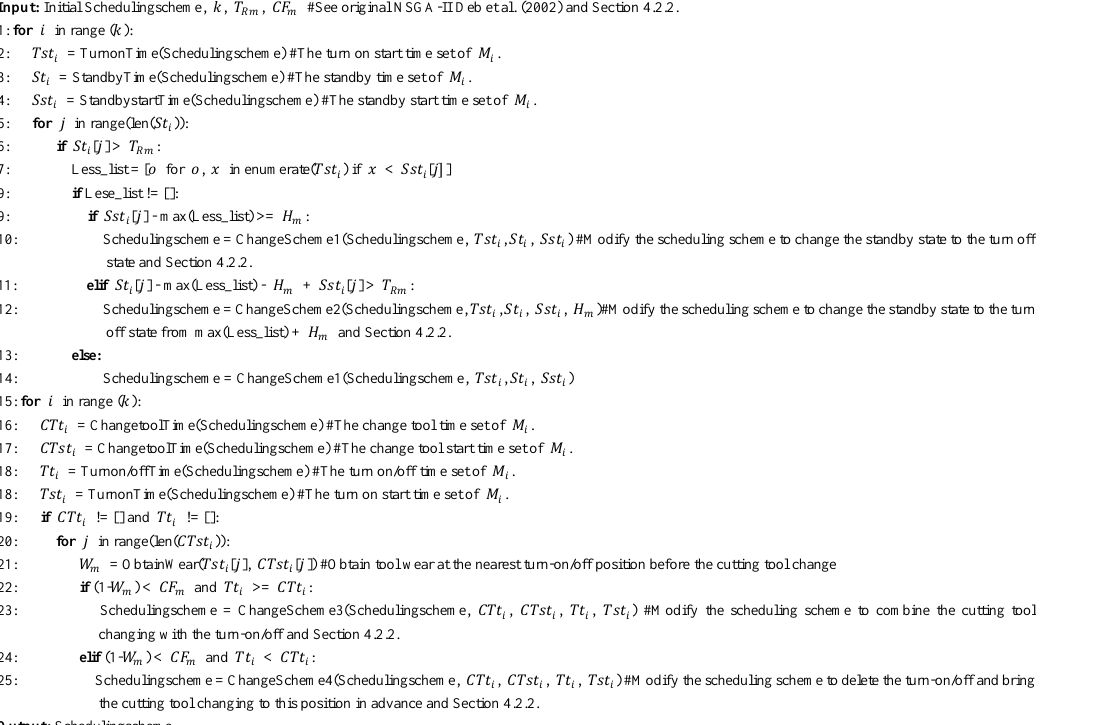
Operation Process Chromosome